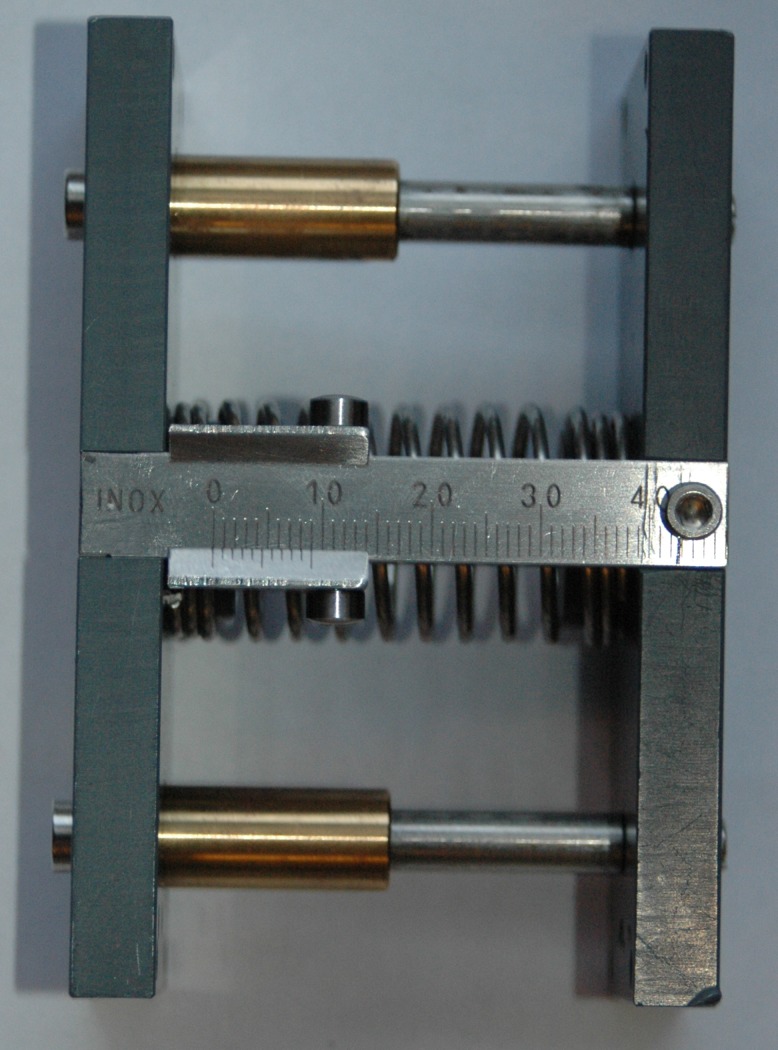
Deformable object.